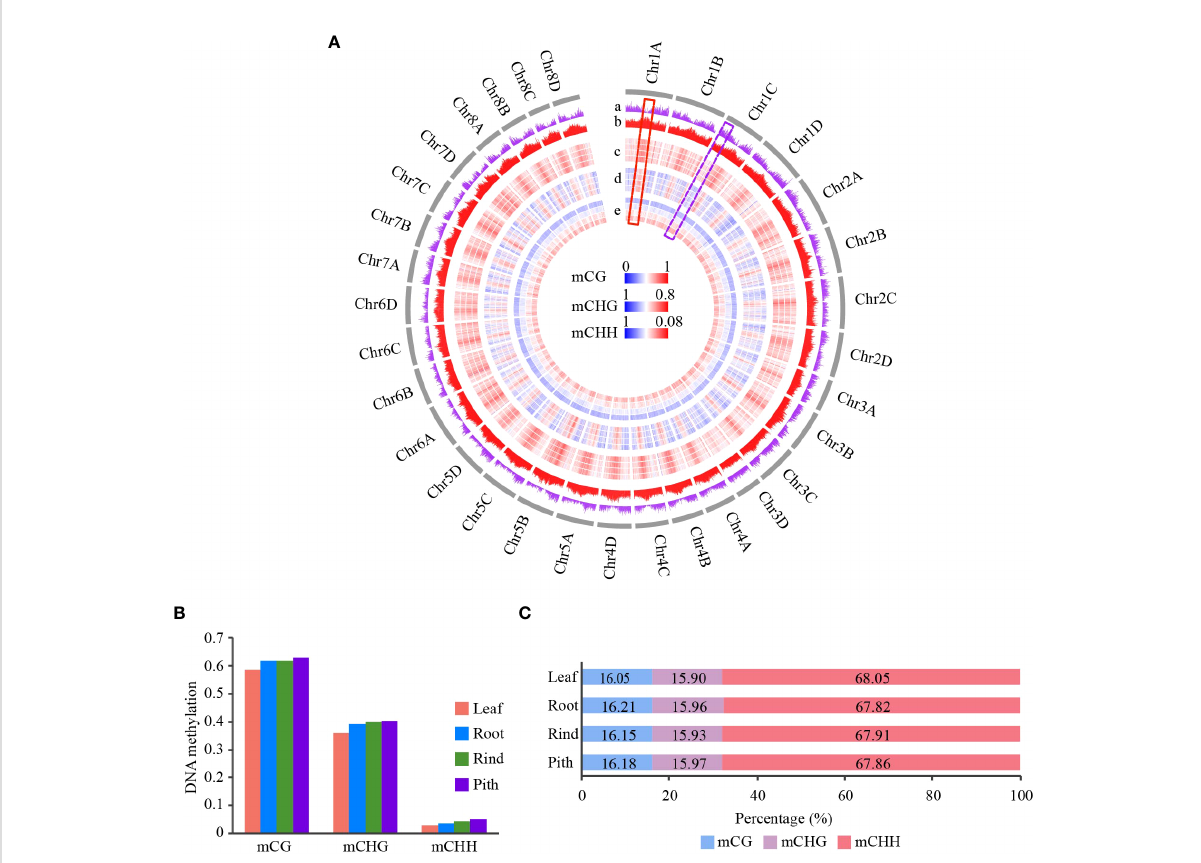
FIGURE 1 Genome-wide DNA methylation pro fi le of different tissues in sugarcane. (A) Circle plot of gene and TE densities and methylation level of CG, CHG, and CHH across 32 homologous chromosomes in sugarcane. DNA methylation level is represented in a heatmap; blue and red indicate low and high methylation levels, respectively. Gene and TE density are represented in a histogram. Average DNA methylation level and gene/TE density are calculated using a 500-kb window. The gray circle indicates chromosomes. From the outer circle to the inner circle: a, gene density; b, TE density (TE density is the ratio of TE length to window length); c, CG methylation; d, CHG methylation; e, CHH methylation. For the DNA methylation circle, the order from outer to inner is Leaf, Root, Rind, and Pith. (B) Global average DNA methylation levels of CG, CHG, and CHH across different tissues in sugarcane. (C) Relative proportion of methyl-cytosines in the three sequence contexts across different